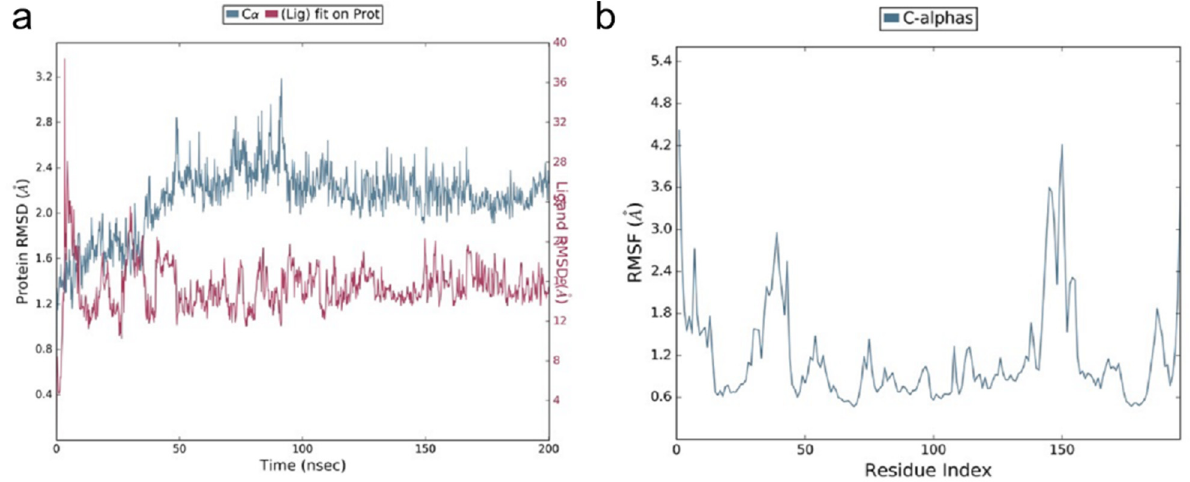
Figure 2. Molecular dynamic simulation study of RBD–PEA complex. ( a ) RMSD profile and ( b ) RMSF profile.